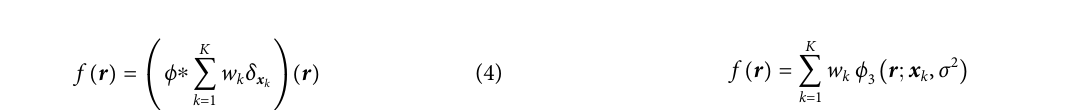
FIGURE 1 | Coarse-grained representation of GroEL/GroES using a varying number of particles (left) atomic structure (PDB code 1aon). Panels (middle left) to (right) show coarse-grained models using K (cid:2) 50 , 300 , and 1000